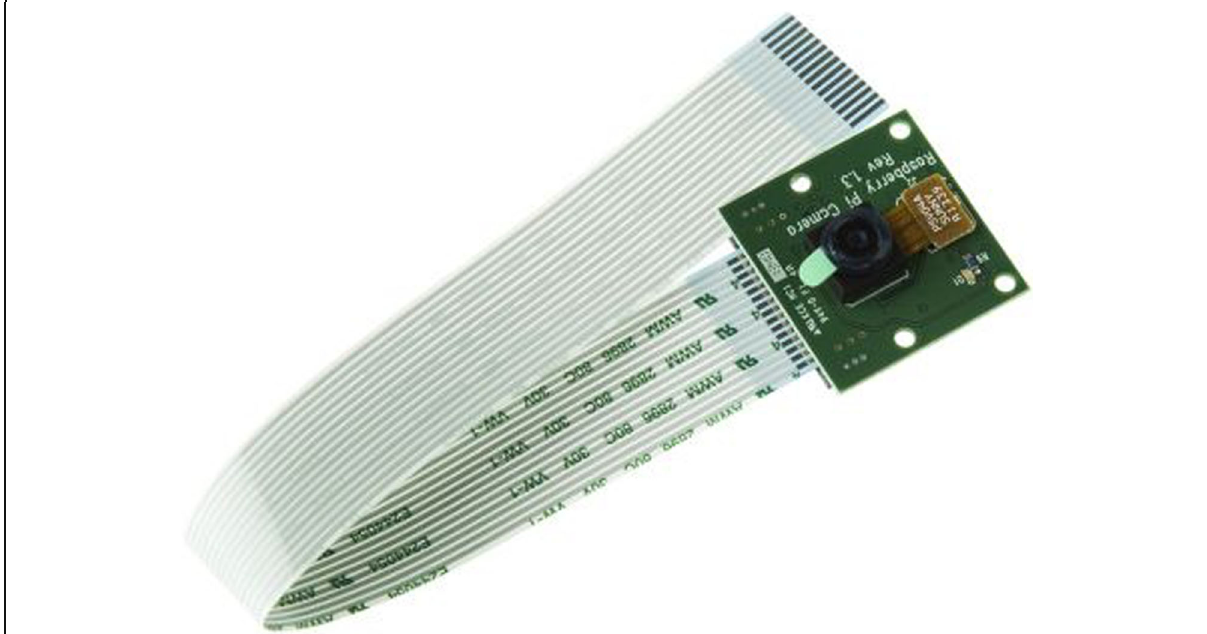
Fig. 3 The front and reverse sides of image sensor node. Figure 3 shows the heads and tails of the image